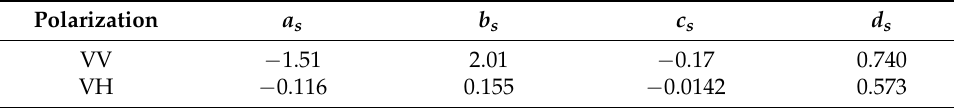
Table 5. The empirical coefficients for Equation (7).